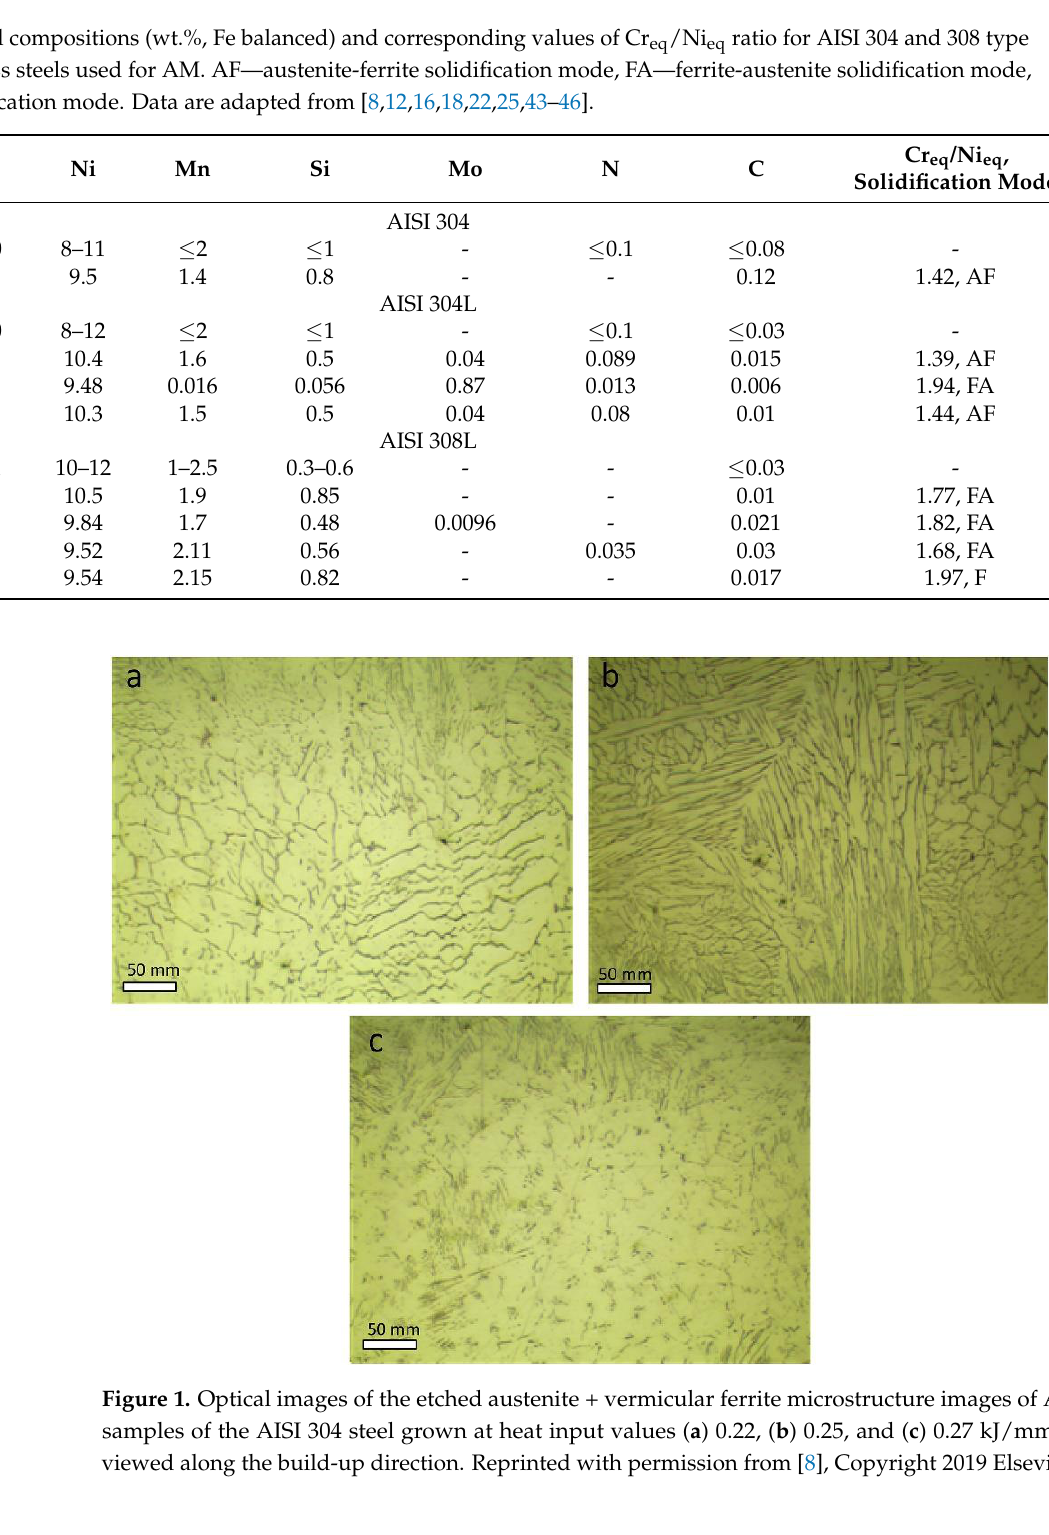
Figure 2. Light microscopy images ( a , b ) and scanning electron microscopy backscattered electron images ( c , d ) of as-built specimens. All images correspond to a cross-sectional surface along the building direction and transverse to the layers. Reprinted with permission from [7], Copyright 2020 Springer Nature. Using selective laser-beam melting (SLM) AM technology and gas-atomized pow- ders of AISI 304L steel (Fe-18.95Cr-9.48Ni-0.87Mo-0.056Si-0.033Cu-0.029O-0.027P- 0.016Mn-0.013N-0.01Co-0.006C-0.001S, wt.%) (Cr eq /Ni eq = 1.94) as the raw material, steel billets with a relative density of 99.9% were produced [12,45]. SLM-fabricated steel had primarily austenitic structure with columnar and dendritic austenitic grains, consisting of